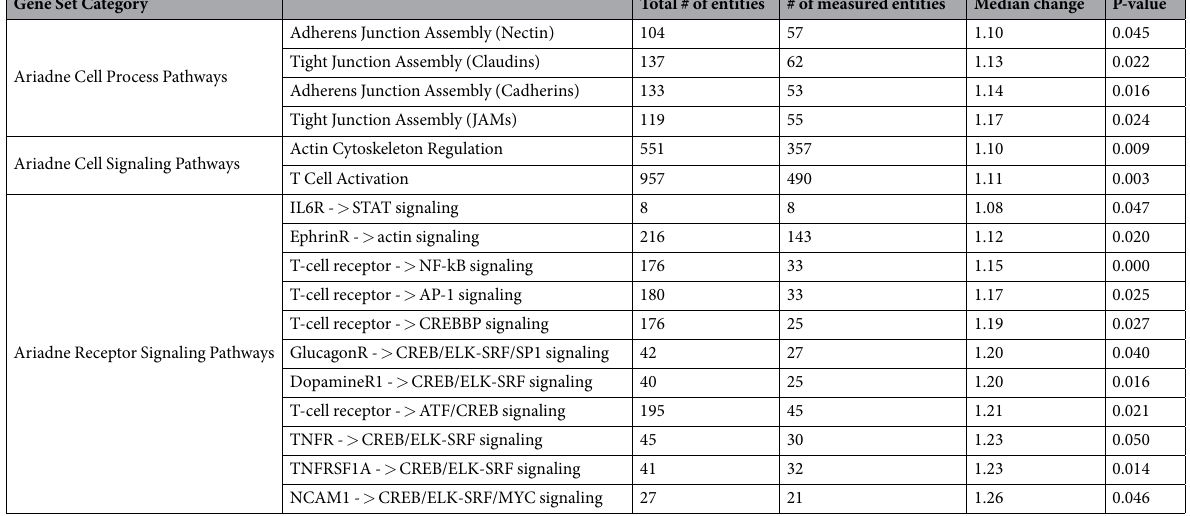
Table 3. Gene set enrichment analysis (GSEA) for transcripts in Carassius auratus RGC cultures treated with 1000 nM SN (P < 0.05). Only those pathways with a median fold-change greater than 5% are presented. The number of measured entities in the pathway is reported along with the number of measured entities and median fold-change for the